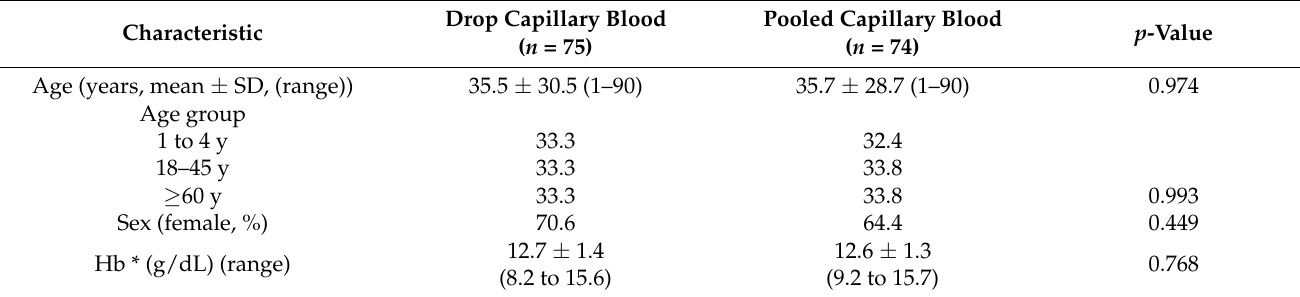
Table 1. Descriptive characteristics of study